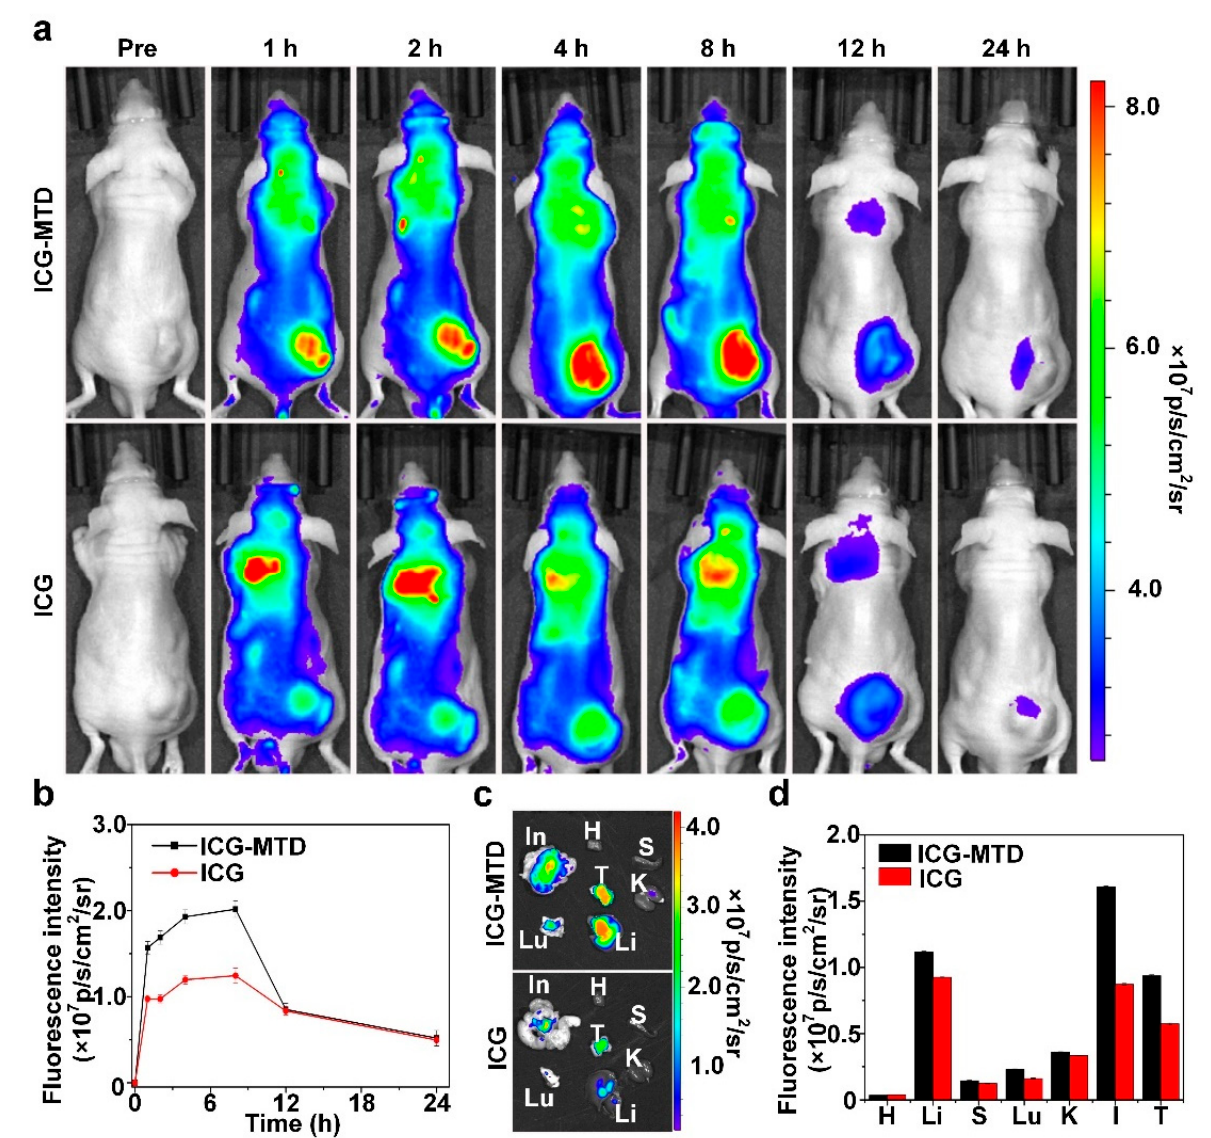
Figure 4. In vivo distribution of MTD: ( a ) fluorescence imaging of 4T1 tumor-bearing mice after tail vein injection with ICG- or ICG-MTD; ( b ) MFI values of the ICG fluorescence following the treatment in ( a ); ( c ) ex vivo fluorescence images of major organs and tumors in mice at 8 h post injection; ( d ) the corresponding MFI analysis at 8 h post injection.